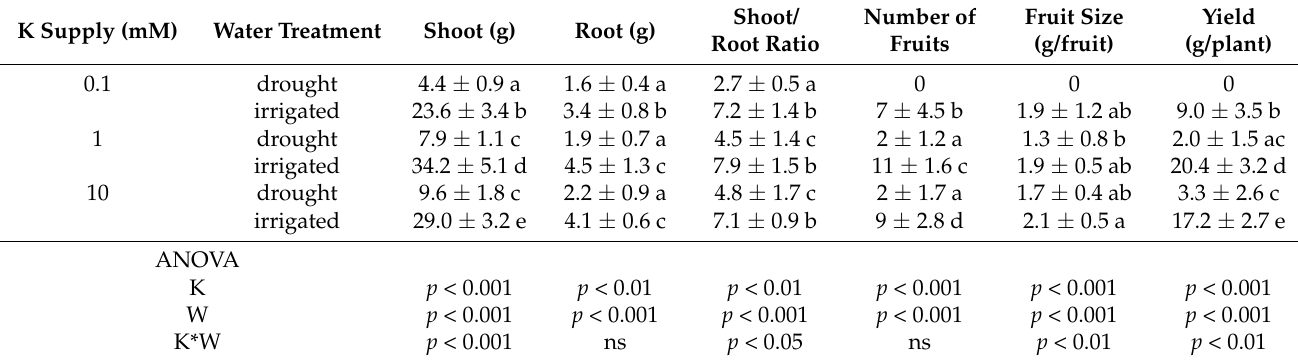
Table 1. Effect of K supply and watering treatment on plant growth and fruit production in tomato. Control plants (irrigated) were compared to plants submitted to six cycles of drying/watering after flower initiation (drought). Means followed by the same letter are not significantly different (LSD Test, p < 0.05). K and W in ANOVA represent potassium and water stress treatment factors,